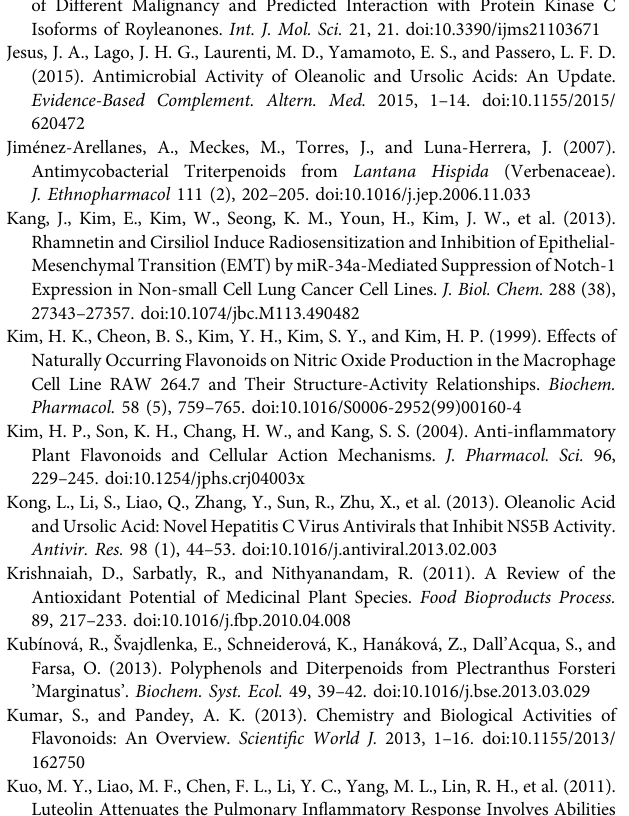
Figueiredo, N. L., de Aguiar, S. R. M. M., Falé, P. L., Ascensão, L., Serralheiro, M. L. M., and Lino, A. R. L. (2010). The Inhibitory Effect of